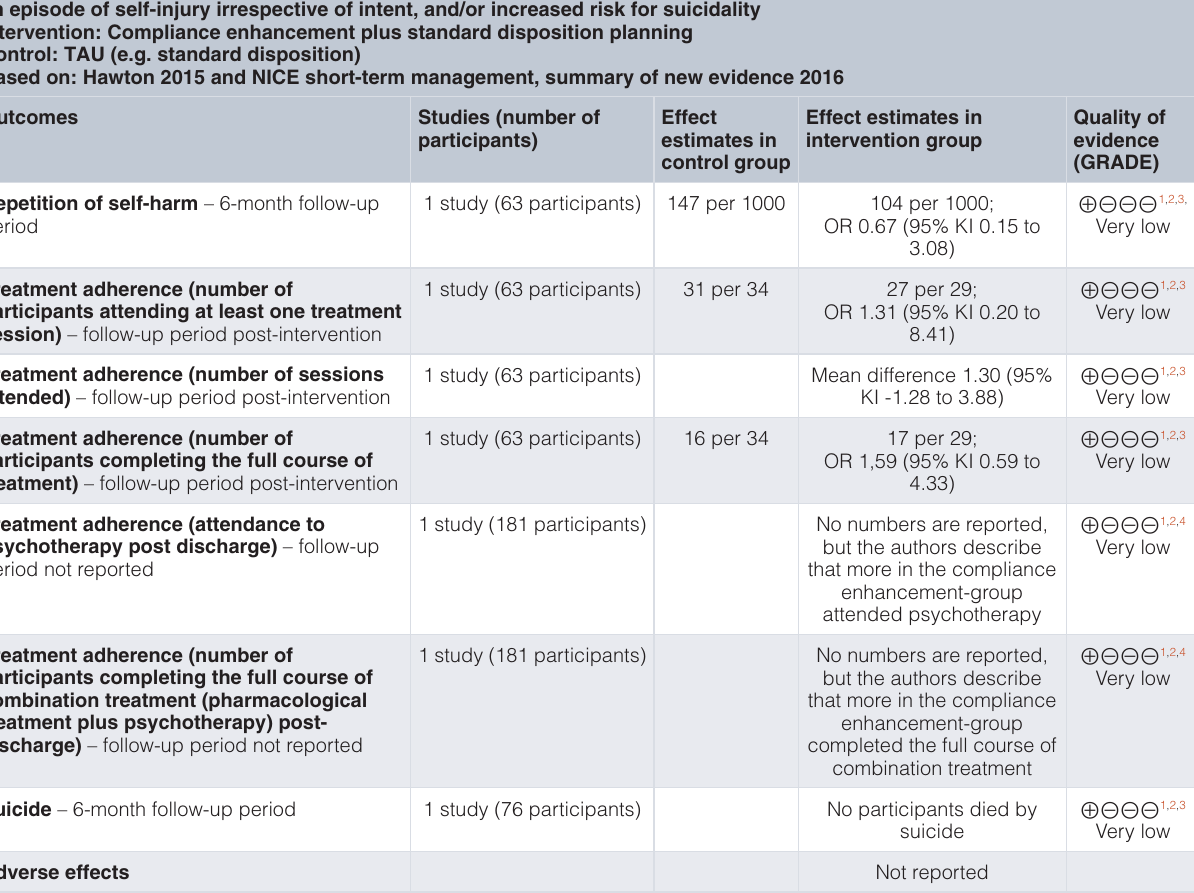
Table 12. GRADE-assessment: Interventions for existing self-harm: compliance enhancement versus TAU. Population: Children and adolescents, 10 to 19-year olds, admitted to the emergency department of a general hospital following an episode of self-injury irrespective of intent, and/or increased risk for suicidality Intervention: Compliance enhancement plus standard disposition planning Control: TAU (e.g. standard disposition) Based on: Hawton 2015 and NICE short-term management, summary of new evidence 2016